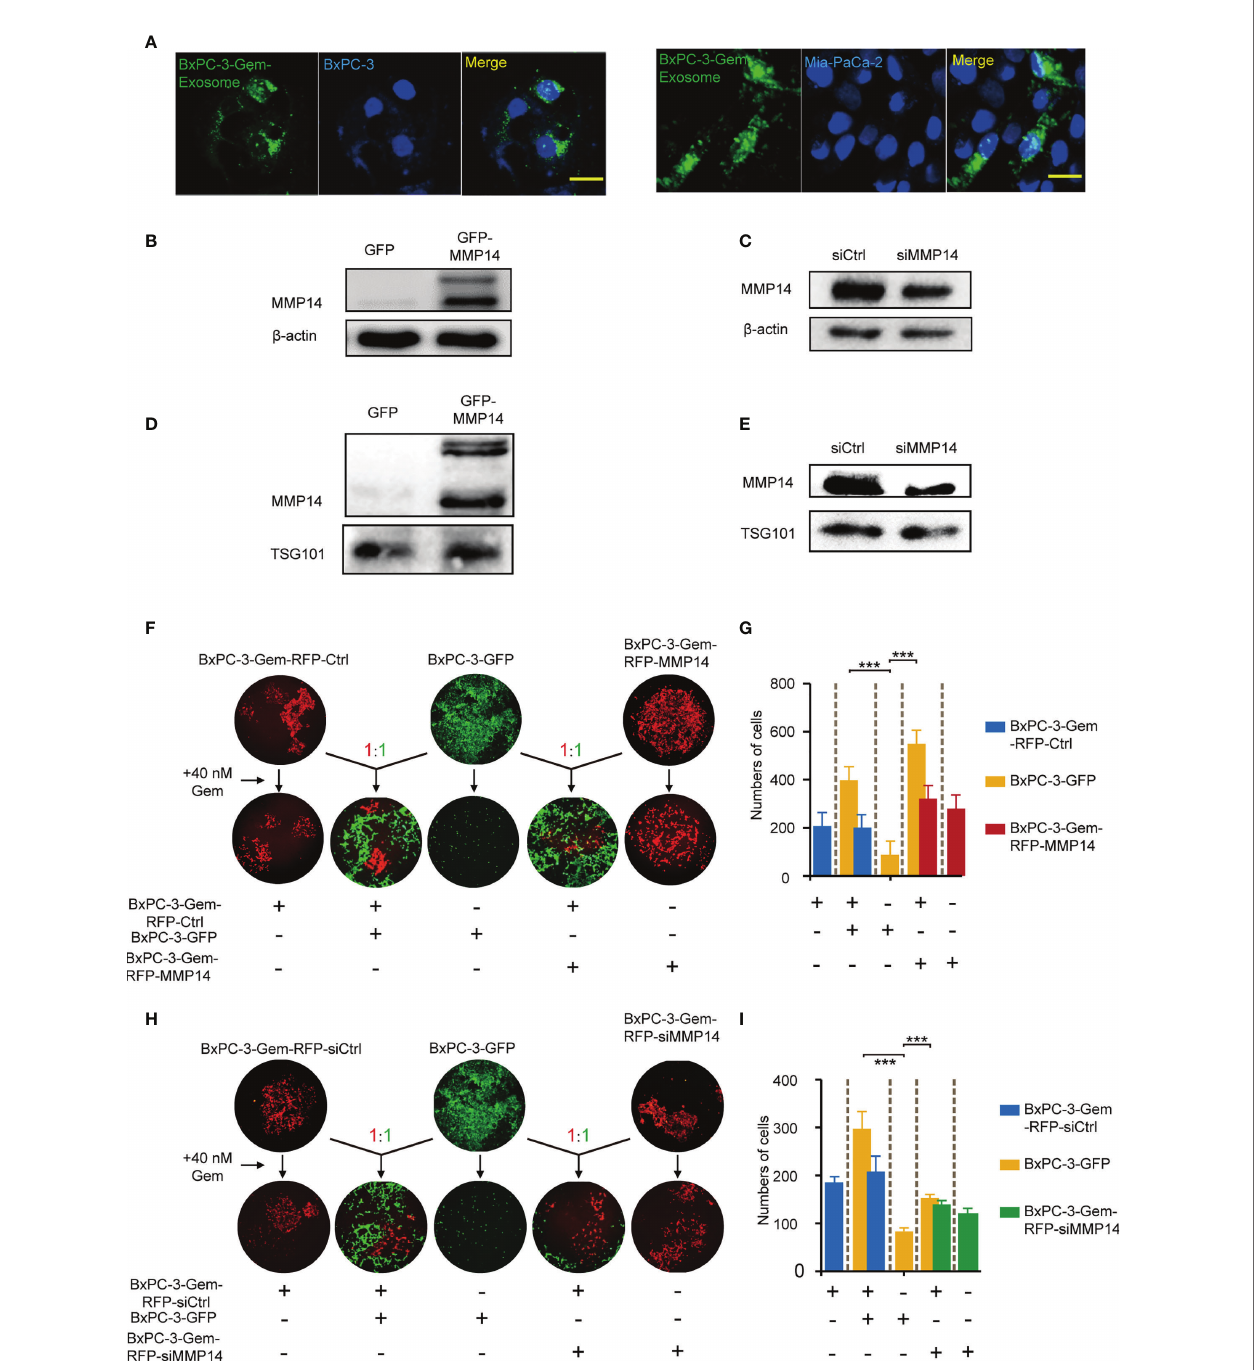
FIGURE 3 | Exosome-transferred MMP14 promotes chemoresistance of the sensitive PDAC cells. (A) Fluorescent observation of BxPC-3 and Mia-PaCa-2 cells after 48-hour incubation with PKH67-labeled (green) exosomes derived from BxPC-3-Gem cells, the nucleus of BxPC-3 and Mia-PaCa-2 cells were stained by DAPI (blue). Scale bar, 25 m m. (B, C) Immunoblotting assays to test MMP14 overexpression (B) or knockdown in BxPC-3-Gem cells (C) . (D, E) Immunoblotting assays to determine MMP14 levels in the exosomes obtained from the cells described in (B) , and (C) (F, G) Colony formation in BxPC-3-GFP cells co-cultured with MMP14- overexpressing or control BxPC-3-Gem-RFP cells at a ratio of 1:1 for 2 weeks, followed by treatment with gemcitabine (40 nM) for 72 hours. Representative images from three independent experiments (F) and average numbers of colonies (G) were shown. (H, I) Colony formation of BxPC-3-GFP cells co-cultured with MMP14 knockdown (si-MMP14) or control BxPC-3-Gem-RFP cells at a ratio of 1:1 for 2 weeks, followed by treatment with gemcitabine (40 nM) for 72 hours. Representative images from three independent experiments (H) and average numbers of colonies (I) were shown. Data in E, G are presented as mean ± SD, *** P <